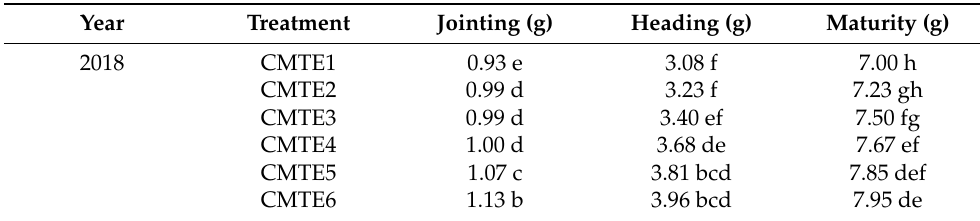
Table 5. Dry weight per stem of rice under different mechanical transplanting methods and plant- ing